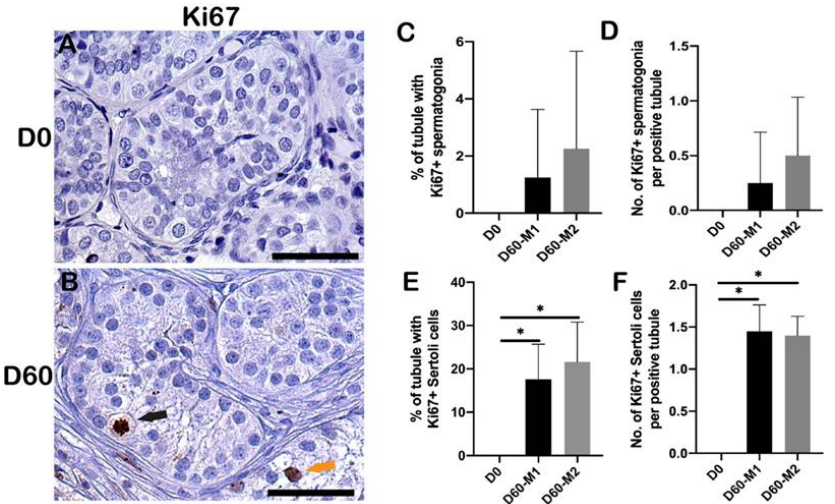
Figure 4. Proliferation of spermatogonia and Sertoli cells. Ki67 positive staining in spermatogonia and Sertoli cells within ITT at D0 ( A ) and D60 ( B ). Black arrow: Ki67-positive spermatogonium; orange arrow: Ki67-positive Sertoli cells. Scale bar = 50 µ m. ( C ) Percentage of tubules with proliferating spermatogonia (positive tubule). ( D ) The number of proliferating spermatogonia per positive tubule. ( E ) Percentage of tubules with proliferating Sertoli cells (positive tubule). ( F ) The number of proliferating Sertoli cells per positive tubule. Asterisks indicated statistically significant differences.